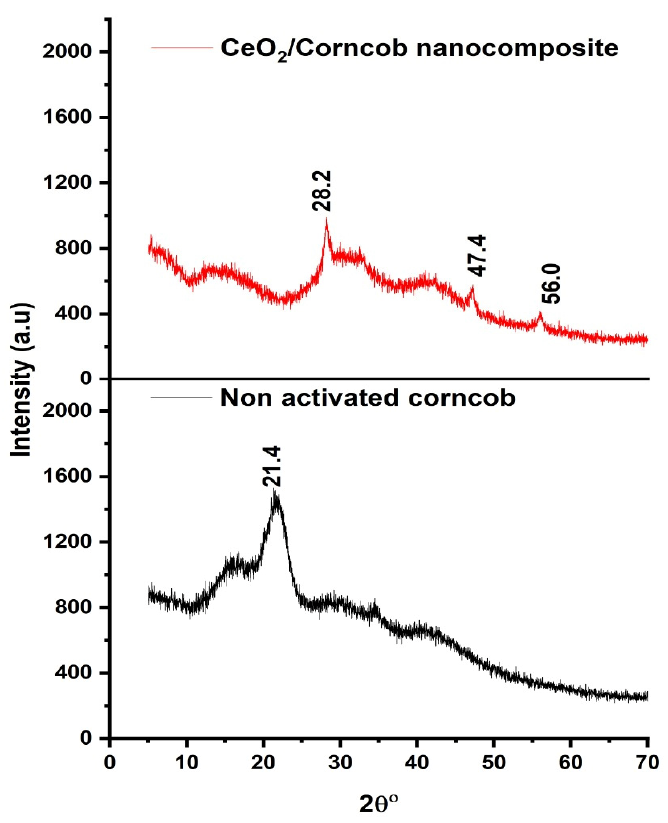
Figure 4. XRD spectra of the corncob and CeO 2 /corncob nanocomposite.